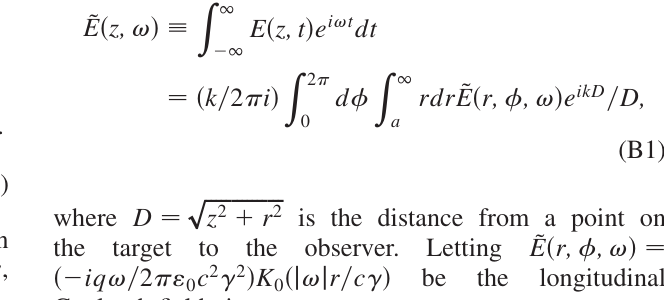
ffiffiffiffiffiffiffiffiffiffiffiffiffiffiffi p z 2 þ r 2